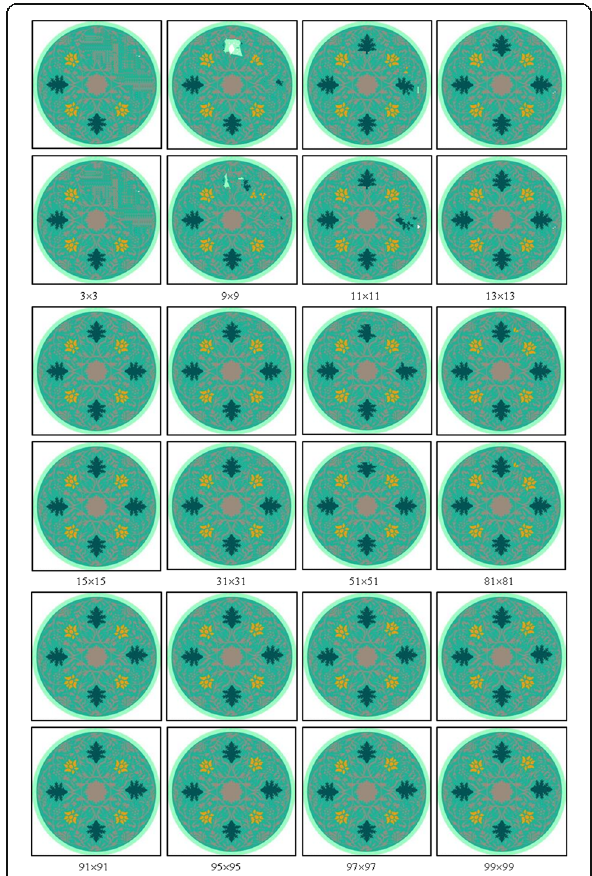
Fig. 12 Inpainting results by Algorithms 2 and 3 of different sized